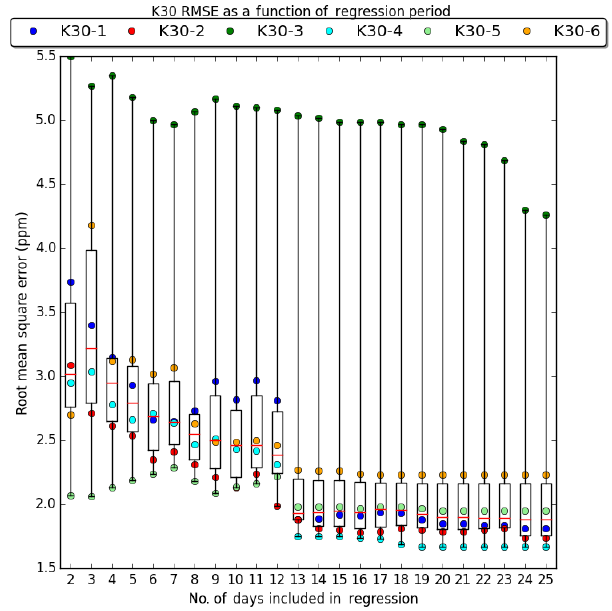
Figure 9. The RMSE of all six K30 NDIR sensors when compared to the LGR over the entire experiment as a function of how many days the regression analysis was performed. The colored dots rep- resent each K30’s RMSE, and the box plot shows the median in red, the first and third quartiles within the box and the min and max values on the